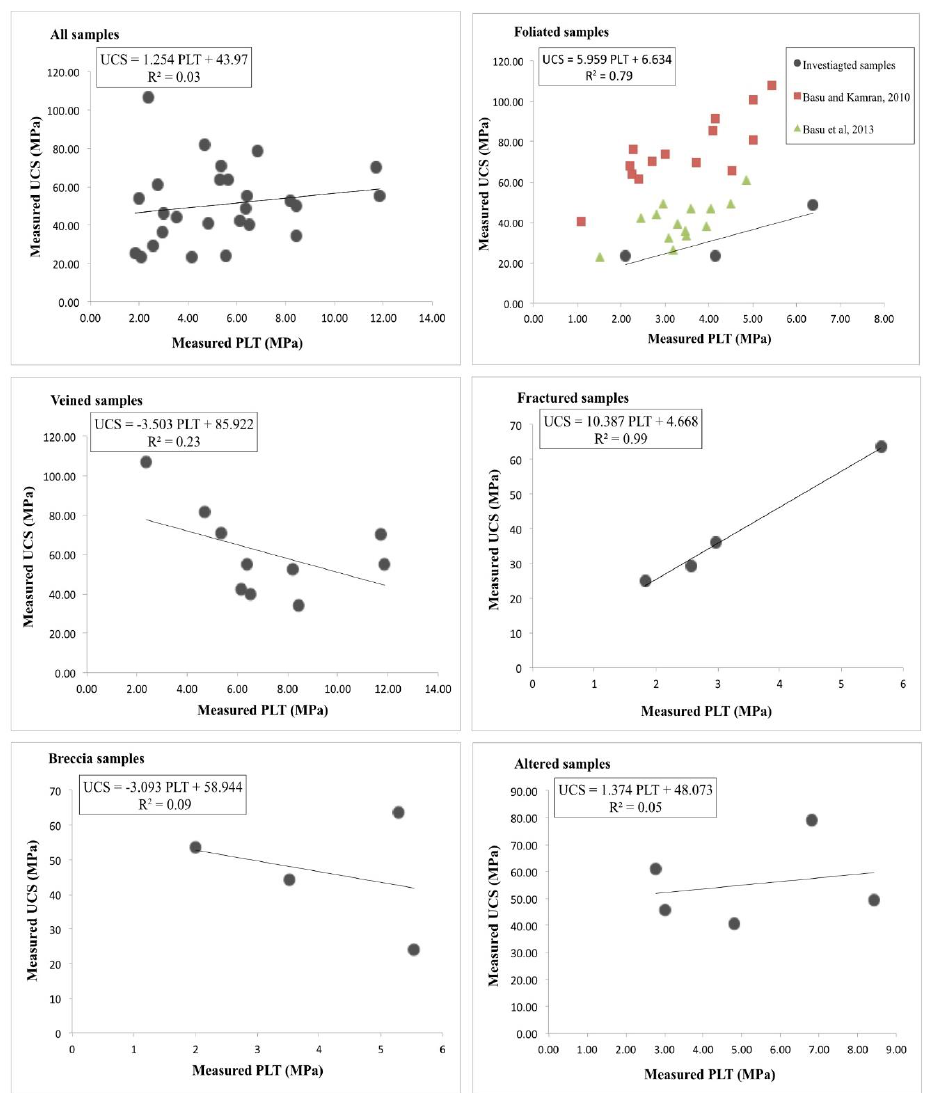
Figure 9. Measured PLT (MPa) vs. measured UCS (MPa) for the investigated rocks. Each plot represents a pre-existing texture. The plot for foliated samples also contains data from the literature [36,40] for schistose rocks. The regression line of best fit is only applied to the investigated rocks.